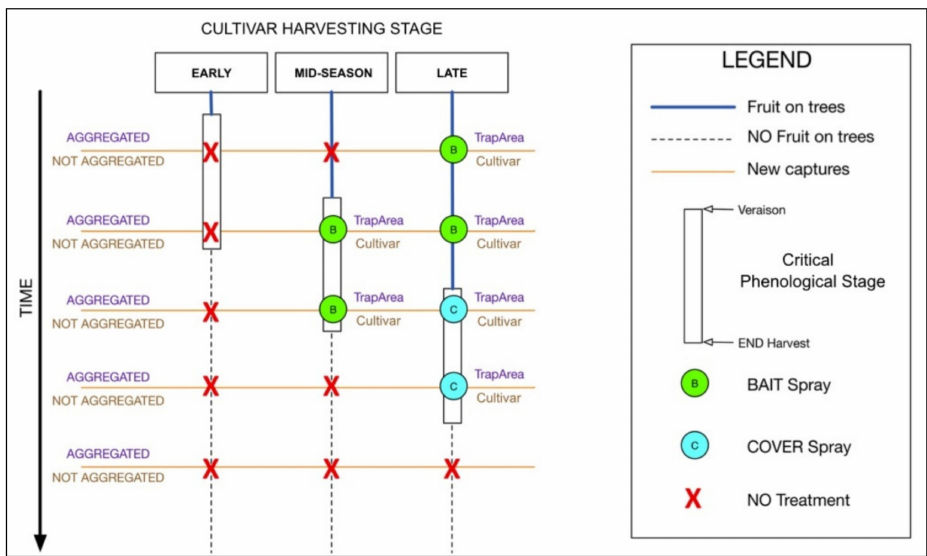
Figure 2. The logic model used in the development of the DSS2 module to define when and where to spray in the Medfly management system. The logic model contemplates three types of fruit based on their harvesting period: early, mid-season, late. DSS2 is initiated once the trees bear fruit. The diagram also schematically provides a period of high sensitivity, marked by the “Critical Phenological Stage”. The type of spray (bait or cover) along the time axis is based on risks, and it depends on “Cultivar Harvesting Stage” and “Critical Phenological Stage”. For example, late cultivars are either treated with cover sprays or baits if the fruit entered the critical phenological stage. The extension of the area to be treated is based on the evaluation of the trapping spatial pattern. If the number of the traps with new captures are < 1 / 3 from the number of the traps of the plot, the trapping spatial pattern is defined as “aggregated” and treatments will be conducted in TrapAreas where new captures occur. If traps with new captures are > 1 / 3, the trapping spatial pattern is defined as “not aggregated” and the treatment will be carried out in all cultivars that are at the same phenological stage.